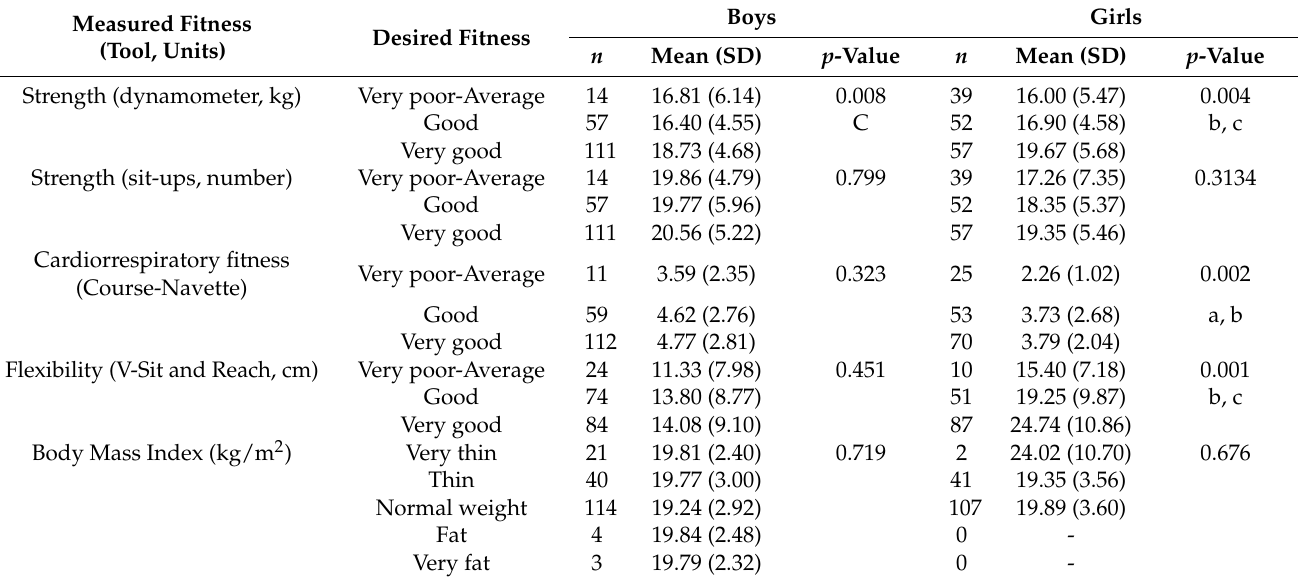
Table 2. Associations between the objectively assessed and desired